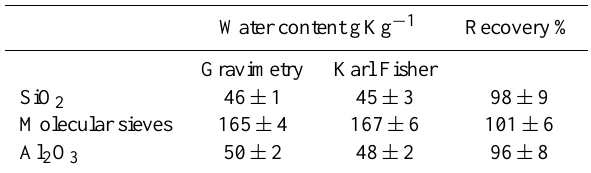
Table 1. Recovery of water from standard materials HYDRANAL (HYD) and Water Standard Oven (WSO). N = 10.